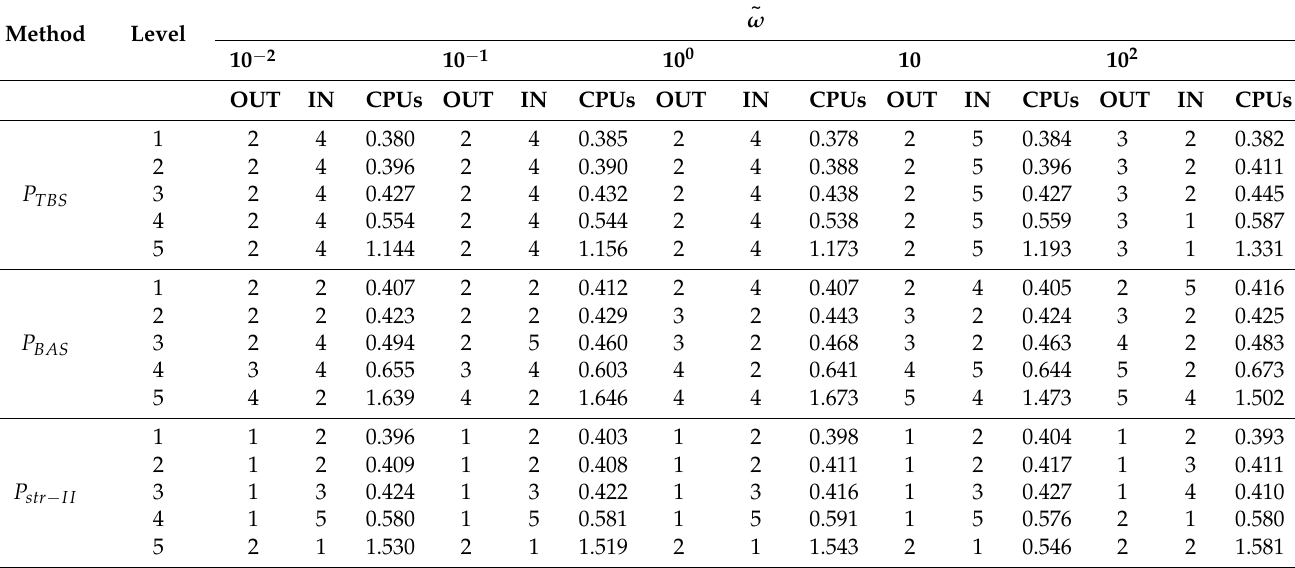
Table 10. Different mesh refinement levels and (cid:101) ω , the result of the preconditioned GMRES (5) in the 2D case, with ε = 10 − 4 .